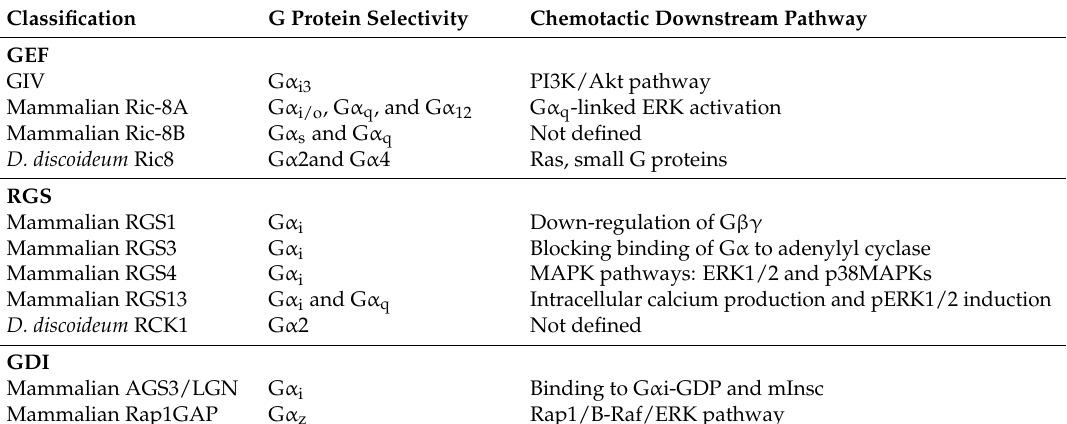
Table 2. Regulation of G α subunit signaling in